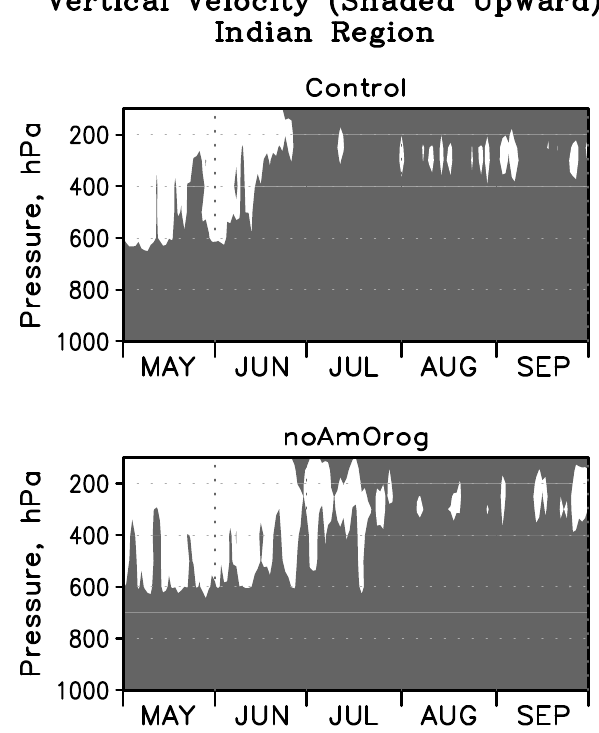
Fig. 18. Vertical profile of vertical velocity over the Indian landmass in control and noAmOrog simulations. Shaded regions indicate up- ward motion and non-shaded downward